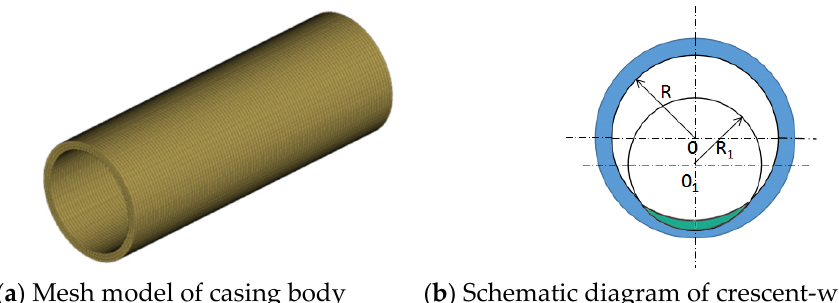
Figure 1. Three-dimensional finite element model of casing body.